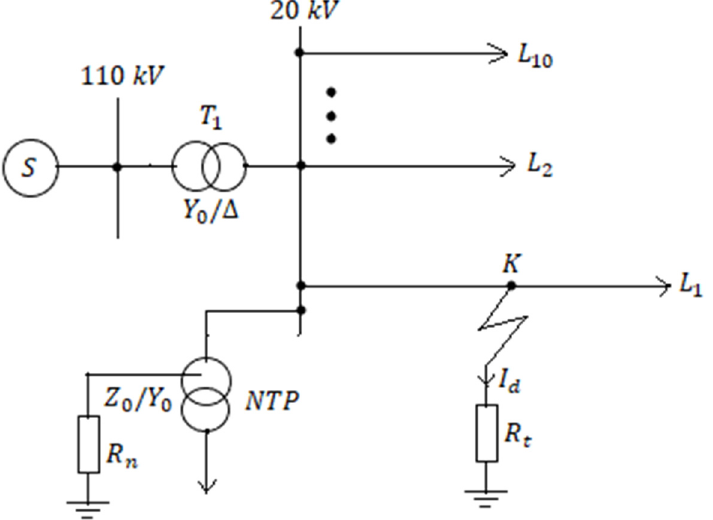
Figure 1. Simplified diagram of the medium voltage electrical network with the neutral connected to ground through the resistor (resistor grounded neutral networks).